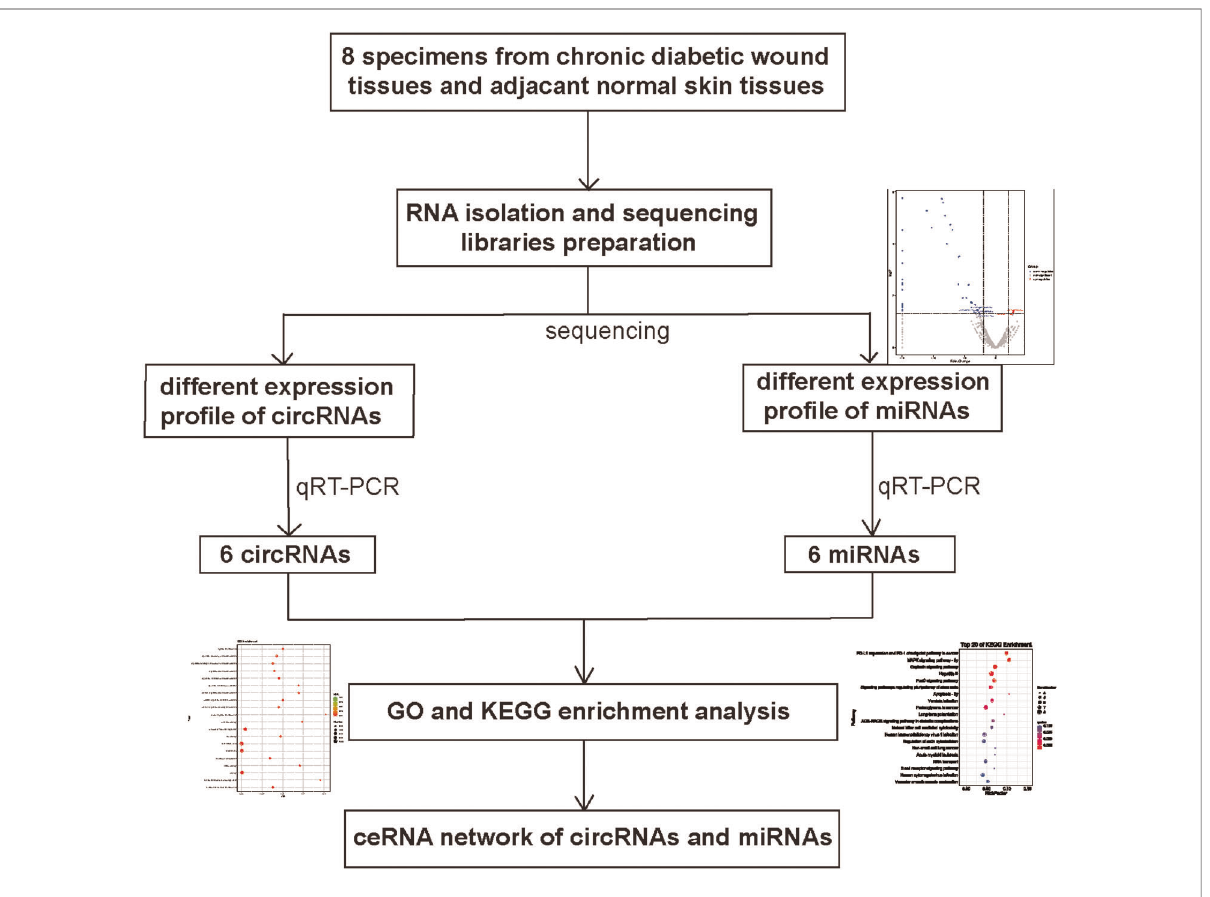
FIGURE 7 Flowchart for circRNA-miRNA network